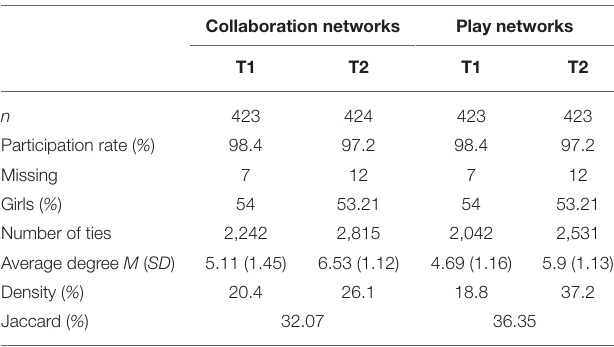
TABLE 1 | Sample descriptives for the collaboration and play networks of the 17 classes included in the social network analyses. Collaboration